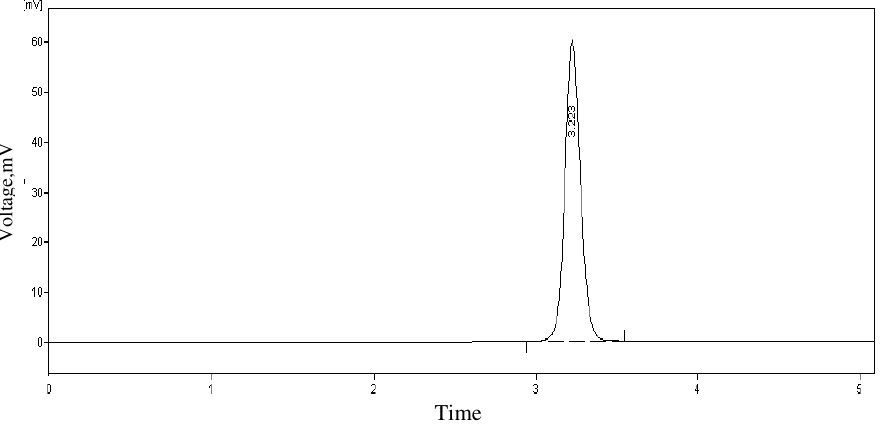
Figure 2 . A typical chromatogram of nevirapine by RP- HPLC Table 3. Intra and inter - day precision for nevirapine assay Concentration of nevirapine